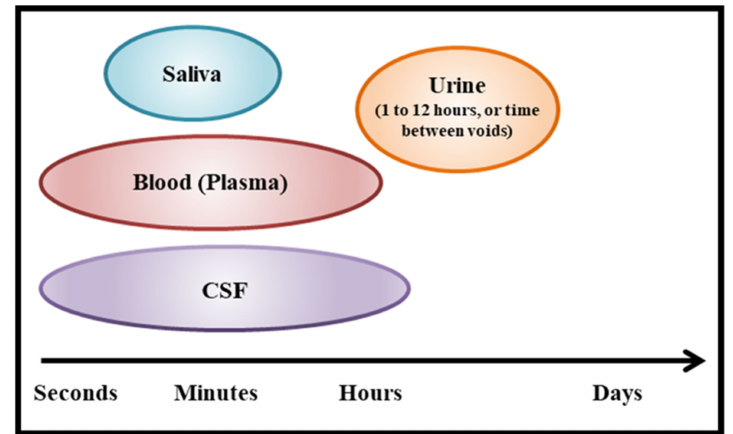
Figure 1. Timescales captured by common bio-sample